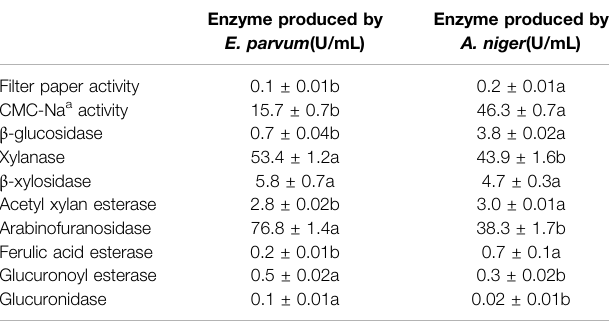
TABLE 2 | Activity pro fi les of the crude enzymes from solid state fermentation by E. parvum and A. oryzae . The activities of crude enzyme extracts from E. parvum and A. niger were conducted for one way analysis of variance (ANOVA) and multiple comparisons, where different lowercase letters indicate signi fi cant difference at p < 0.05 probability